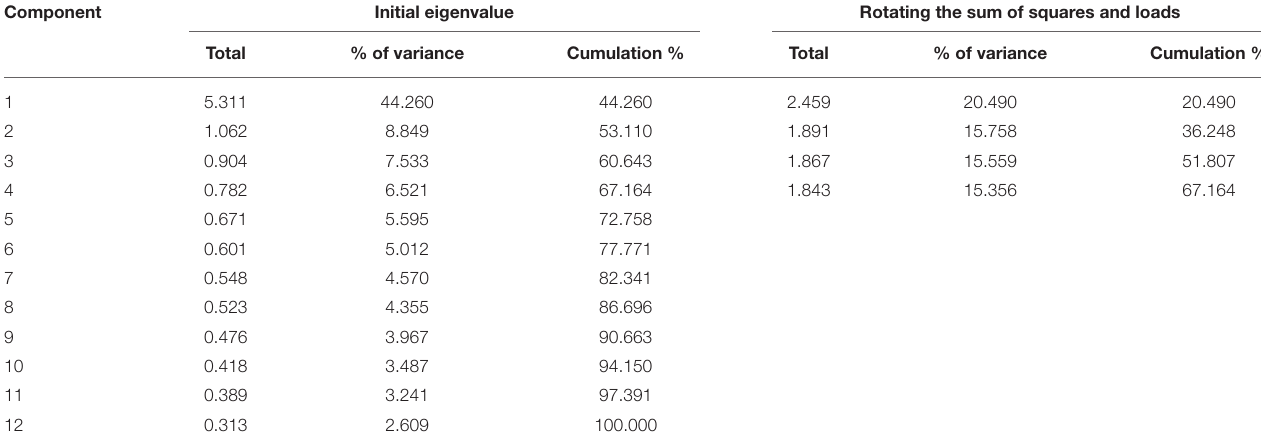
TABLE 8 | Total variance interpretation.